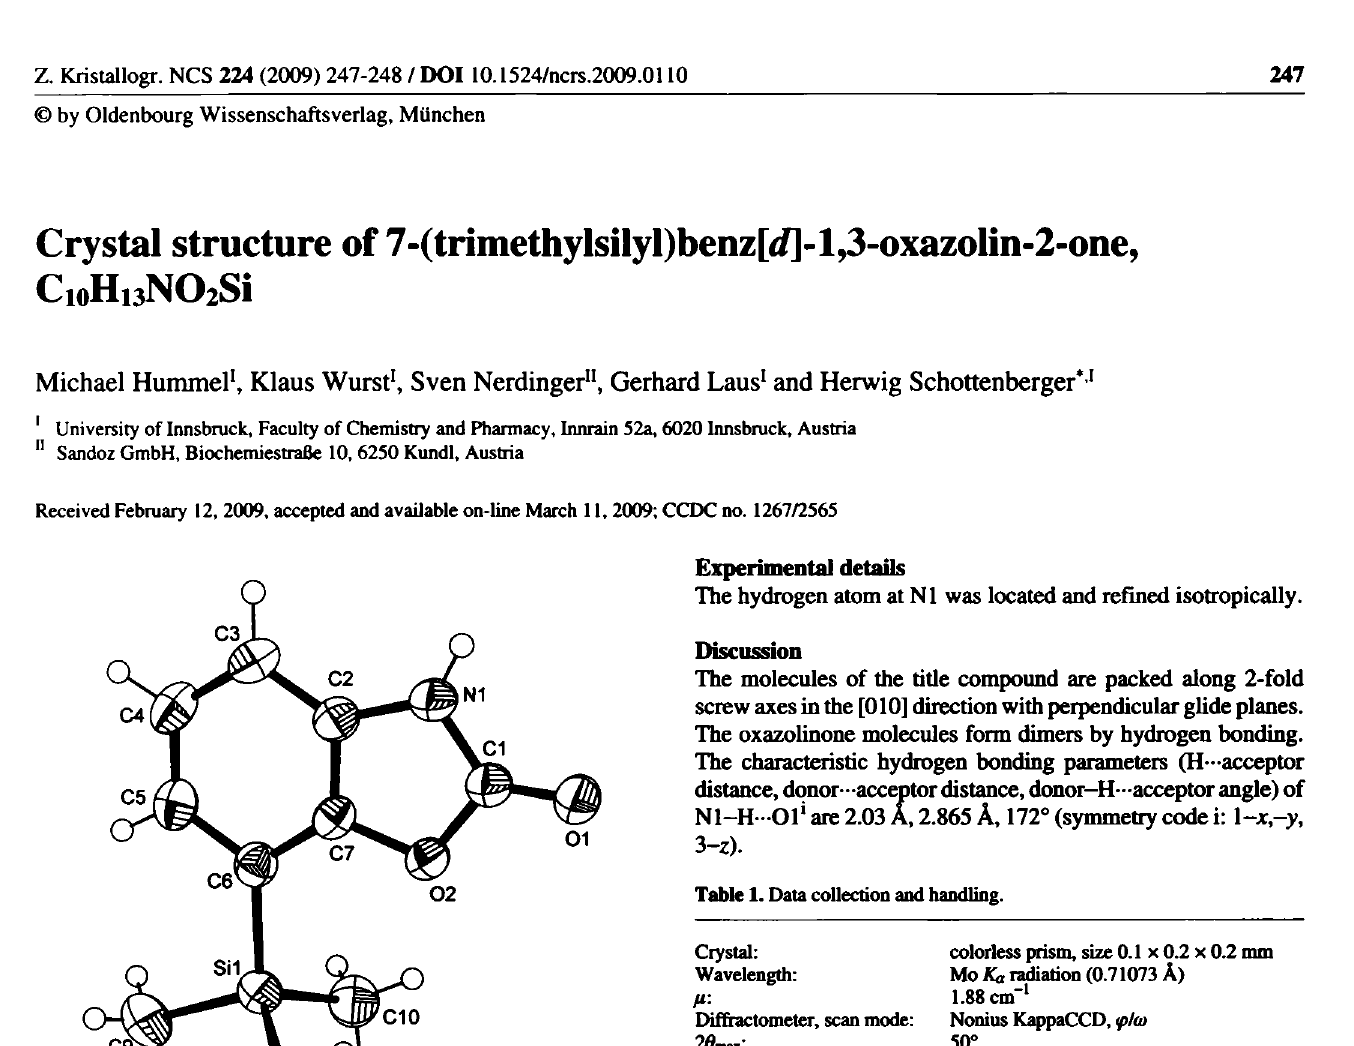
Table 2. Atomic coordinates and displacement parameters (in Â 2 ).